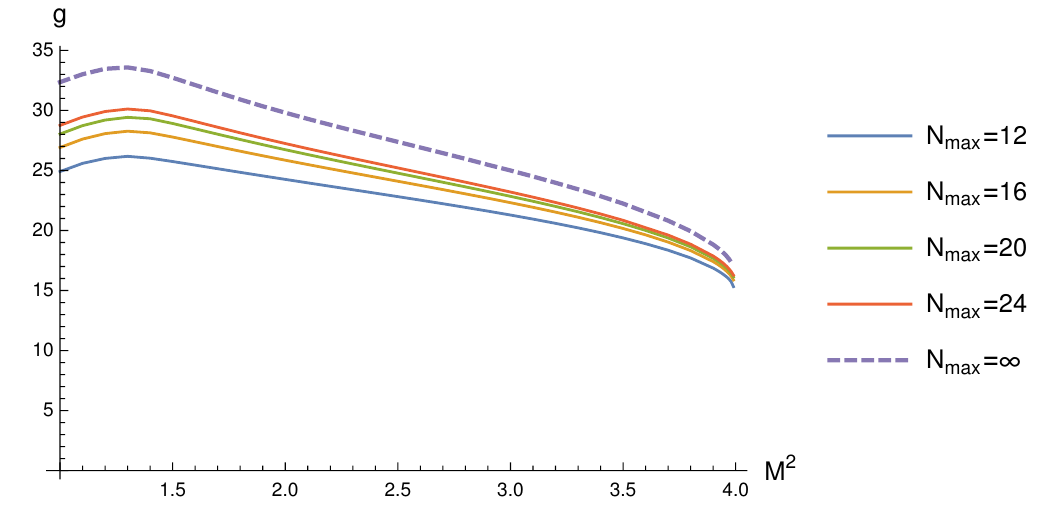
Figure 5 . Upper bound on the cubic Yukawa coupling g as a function of the scalar particle mass M . The bound is constructed for N max = 12 , 16 , 20 , 24 and L max = N max + 20 . Using N max = 20 and N max = 24 we also perform a linear extrapolation of the bound to N max = ∞ . The latter is indicated by the dashed line.